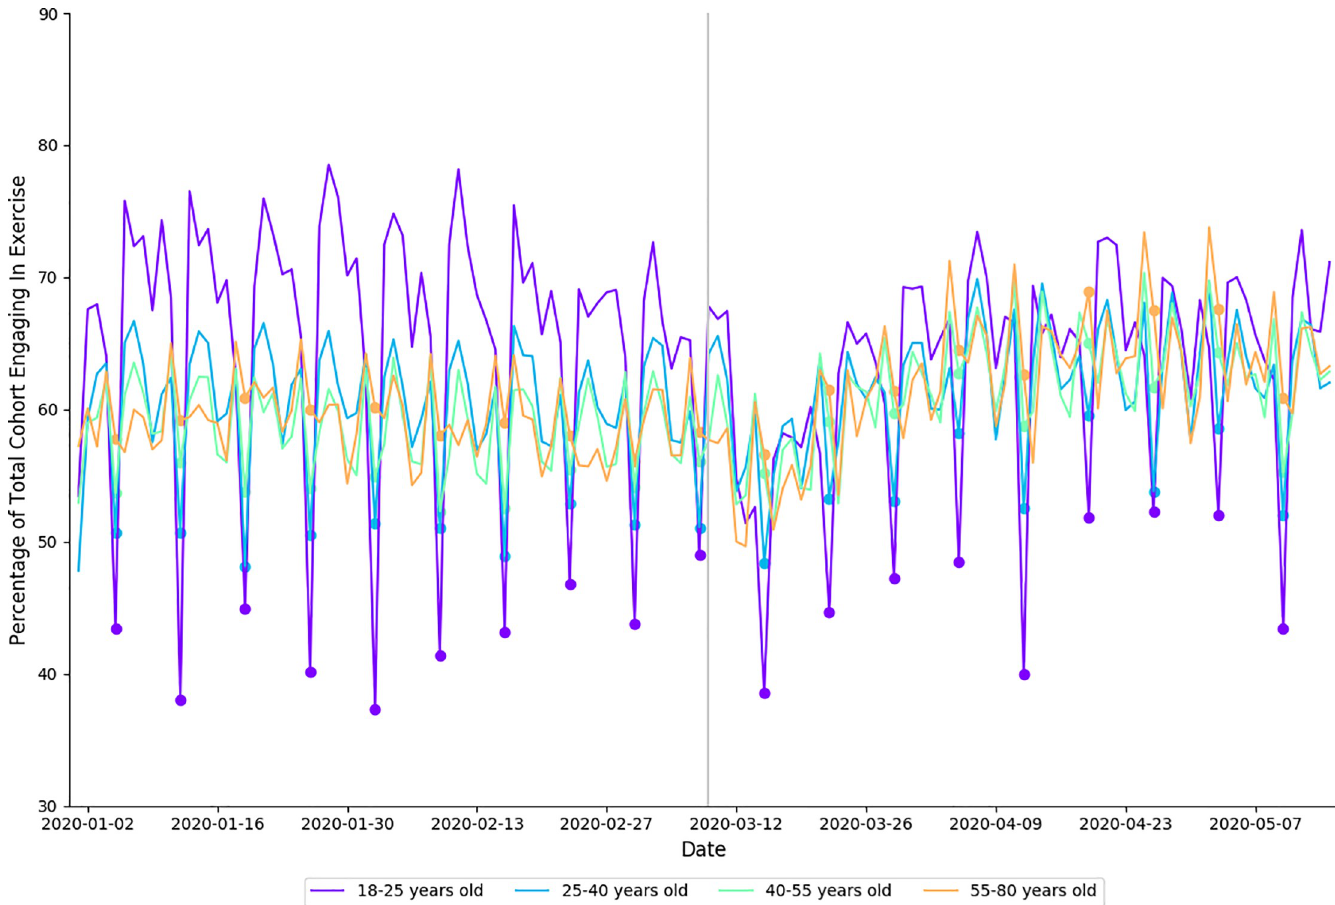
Fig 3. Percentage of each age cohort in 2020 that logged an exercise session, by date. Each cohort is shown in a different color, indicated in the legend. Filled circles indicate Sundays, a vertical gray line separates baseline from physical distancing.